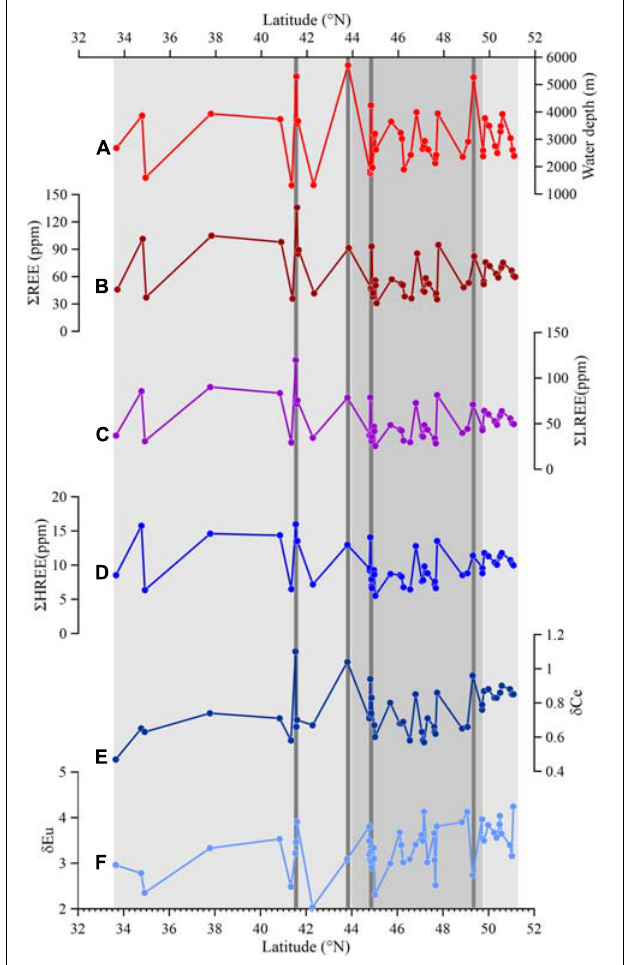
FIGURE 7 | Spatial trends of rare earth elements and related proxies. The spatial variation of water depth (A) , spatial variation in the content of (cid:54) REE (B) , spatial variation in the content of (cid:54) LREE (C) , spatial variation in the content of (cid:54) HREE (D) , spatial variation of δ Ce (E) and spatial variation of δ Eu (F) .